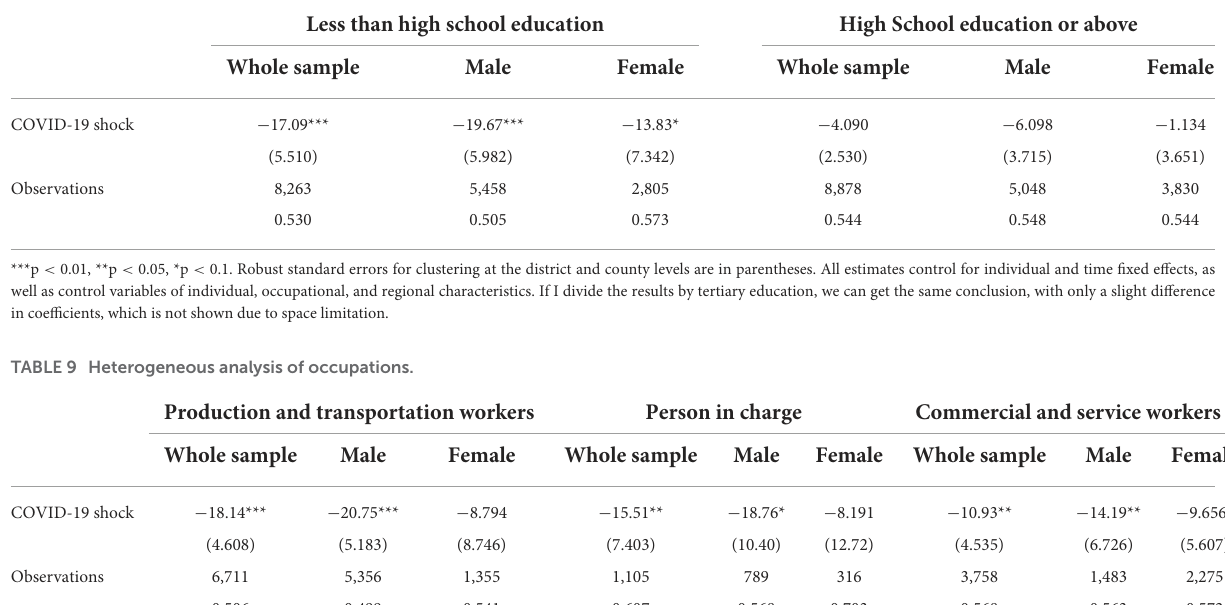
TABLE 8 Heterogeneous analysis of education.